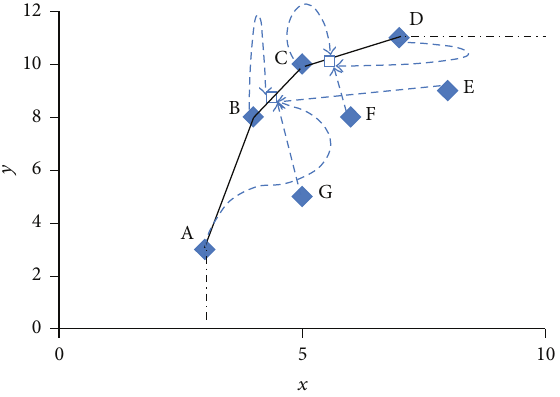
Figure 4: The CRA-SBMI projections onto the frontier